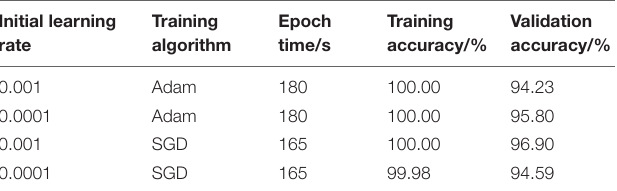
TABLE 1 | Training results of Corn-seed-Net with different model parameters. Initial learning Training rate algorithm